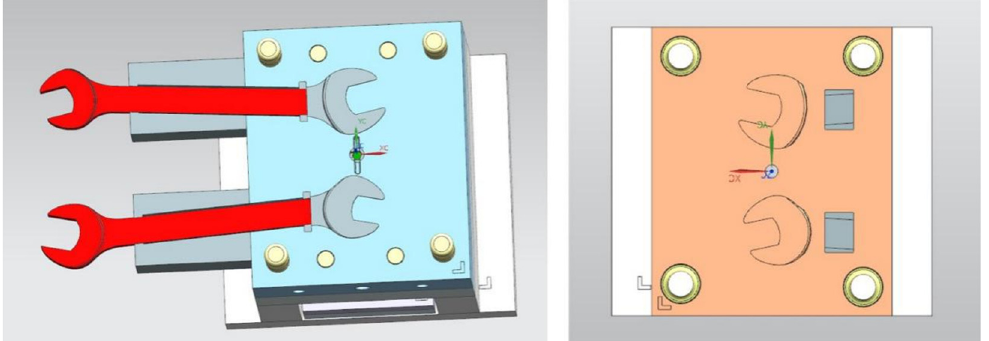
Figure 13: Wrench tool injection polymer plastic sleeve mold design